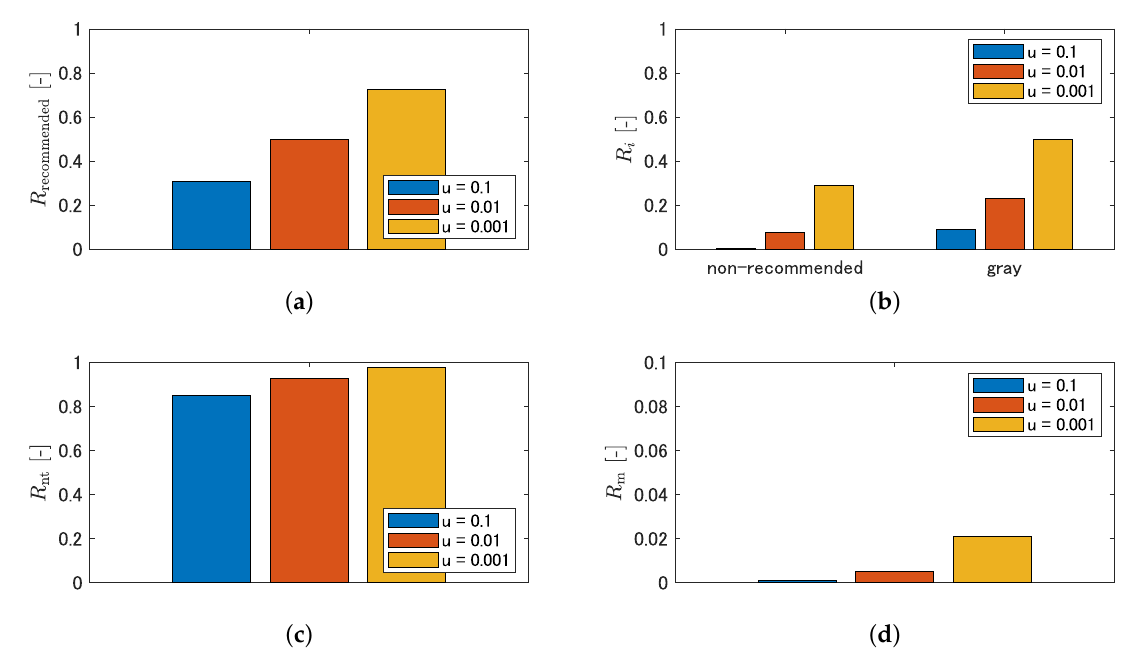
Figure 15. Quantitative characterization by varying loss weight for unclassified area: ( a ) detection rate of recommended area; ( b ) detection rate of non-recommended area and gray area; ( c ) detection rate of non-traversable area; and ( d ) misclassification rate of the non-traversable area.